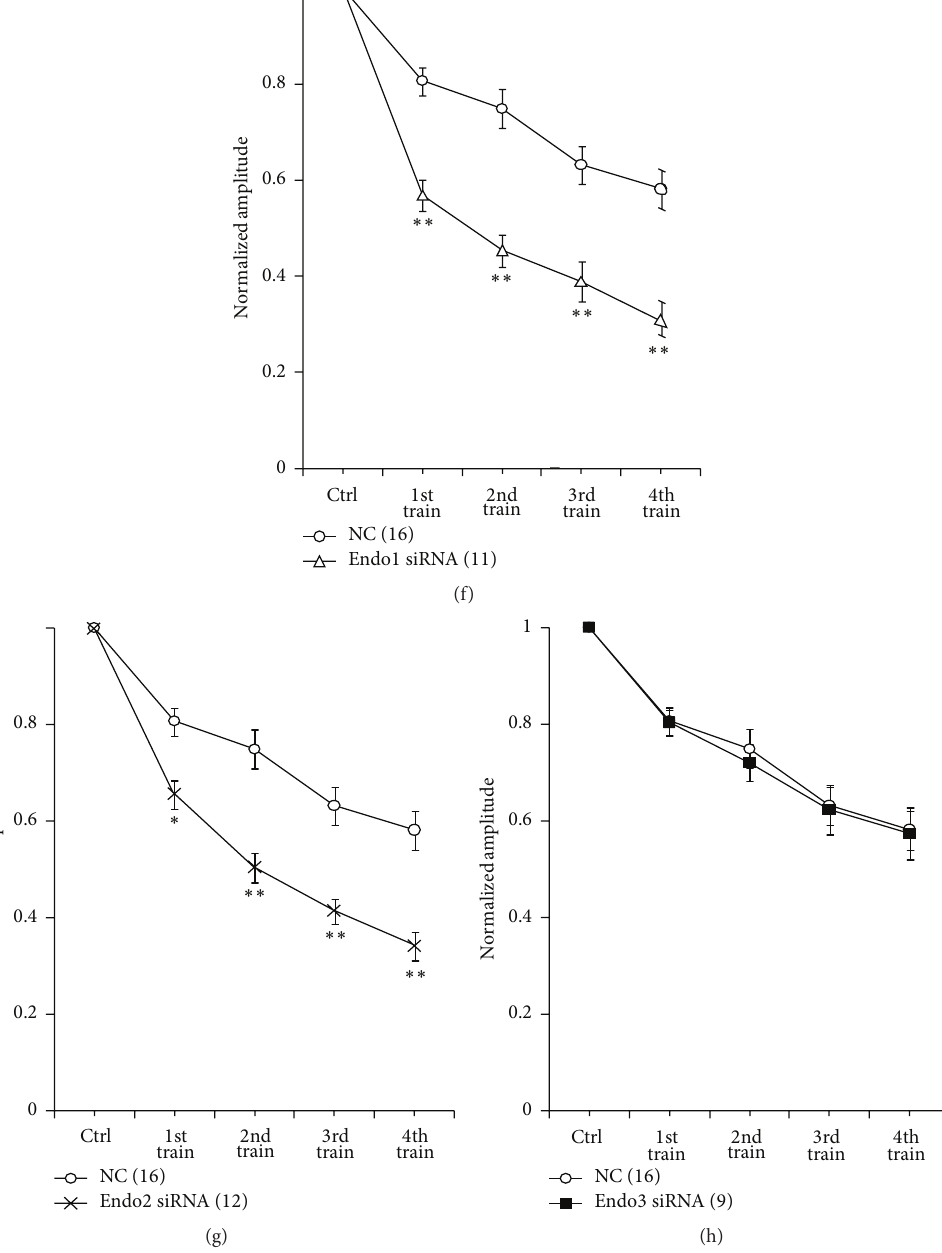
Figure 3: Quantitative analysis of endophilin isoform knockdown on sustained neurotransmitter release. (a) Representative traces of excitatory postsynaptic currents (EPSCs) in nontransfected neurons evoked by 100 pulses at 5 Hz in neurons transfected with control or endophilin siRNA. (b–d) Changes in short-term synaptic depression (STD) in nontransfected neurons evoked by stimulation of 100 pulses at 5 Hz in neurons transfected with endophilin siRNA ((b), Endo1 siRNA, 𝑛 = 13 ; (c), Endo2 siRNA, 𝑛 = 8 ; and (d), Endo3 siRNA, 𝑛 = 12 ). (e) Average normalized amplitude of the last 20 responses in endophilin siRNA-transfected neurons compared with that in scrambled negative control- (NC-) transfected neurons; ∗∗ 𝑝 < 0.005 . (f–h) Normalized amplitude of EPSCs evoked by multiple train stimulations in neurons transfected with NC or endophilin siRNA. (f), Endo1 siRNA, 𝑛 = 11 ; (g), Endo2 siRNA, 𝑛 = 12 ; and (h), Endo3 siRNA, 𝑛 = 9 . ∗ 𝑝 < 0.05 , ∗∗ 𝑝 < 0.005